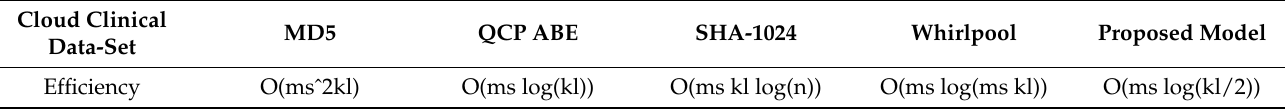
Table 1. Conventional Hash Technique-based proposed model efficacy.